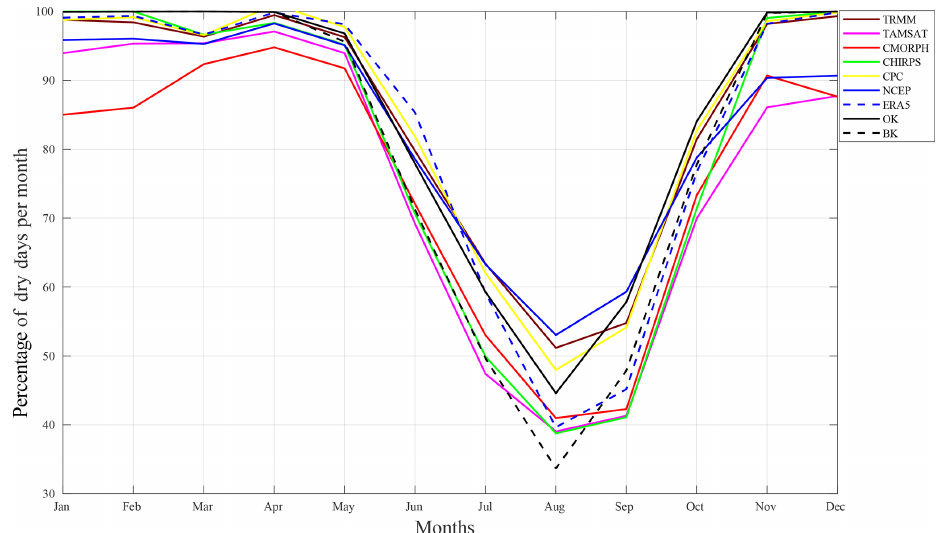
Figure 5. Percentage of average dry days ( ≤ 1mm) per month computed for the overlap period between datasets (1998–2010) and for all grid points in each dataset: TRMM, TAMSAT, CMORPH, CHIRPS, CPC, NCEP, ERA5, BK, and OK.